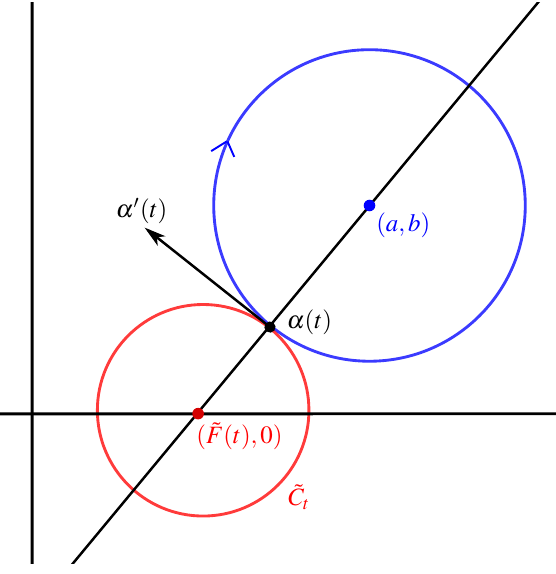
Figure 10: The canonical circle at α ( t ) in the case that A s is oriented